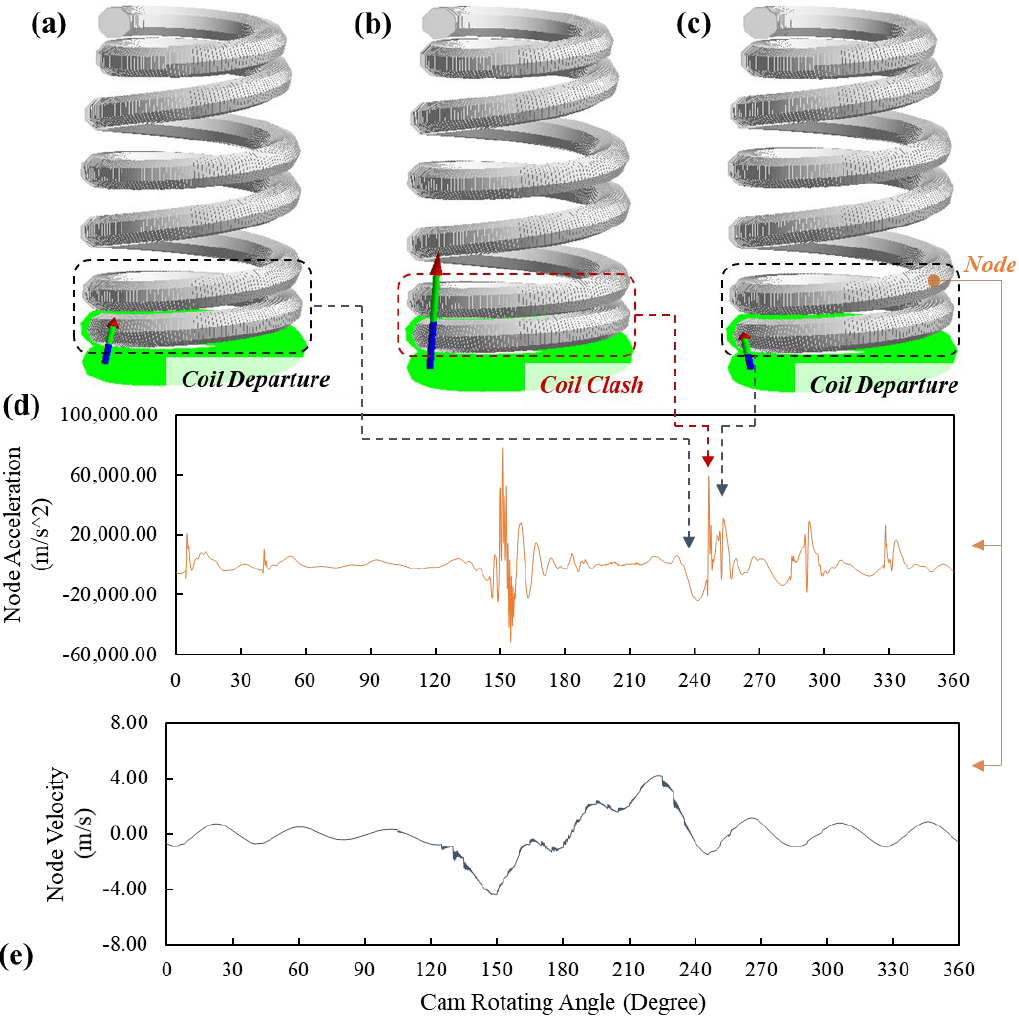
Figure 9. The motion status of the FE spring model at ( a ) 255-degree, ( b ) 256-degree and ( c ) 257-degree cam angles and the ( d ) acceleration and ( e ) velocity of the node on the third coil from the lower spring end.